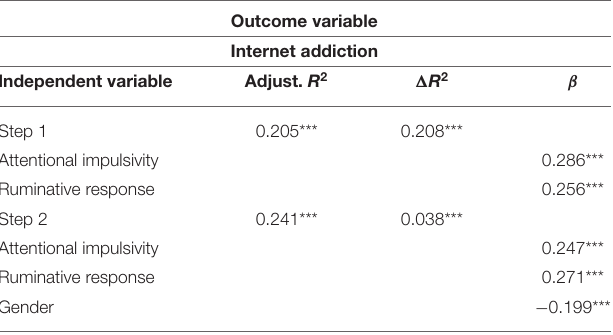
TABLE 6 | Results of hierarchical linear regression analyses inserting attentional impulsivity.